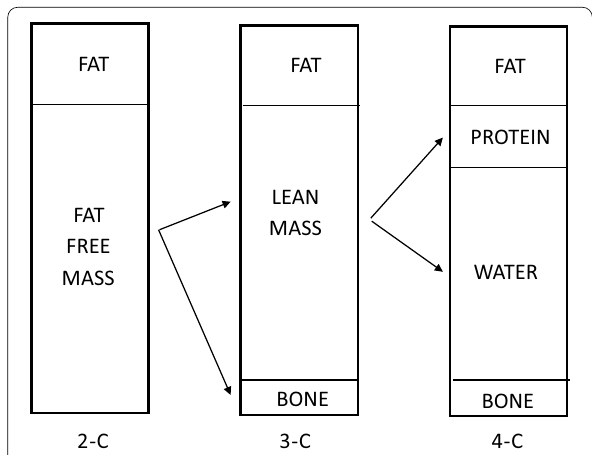
Fig. 1 Models of body composition. In the two‑compartment model (2‑C), the body is divided into “fat” and “fat‑free” mass compartments. In the three‑compartment model (3‑C), the fat‑free compartment is divided into bone and lean mass. In the four‑compartment model (4‑C), the lean mass compartment is divided into protein and water